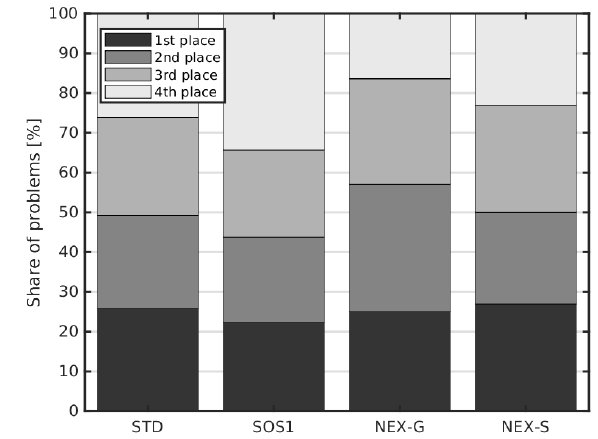
Figure 10 . DCT ranking (1 st , 2 nd , 3 rd and 4 th places) of the MLD control approaches, for all problems